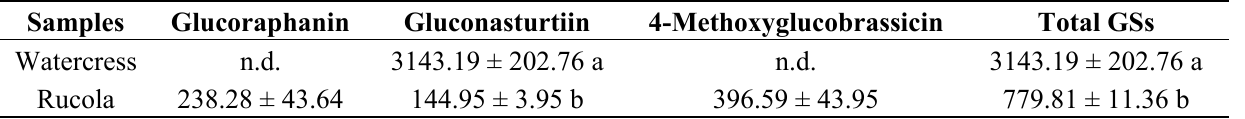
Table 3. Average GSs content quantified by HPLC in baby-leaf salads samples, expressed as μ mol.100 g − 1 of DW 1,2,3 .